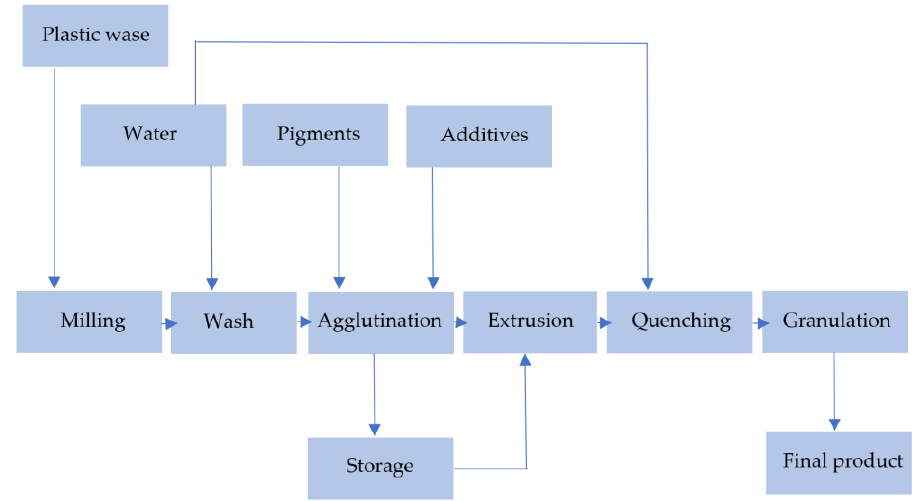
Figure 13. Steps of mechanical recycling. Made based on [31,37].